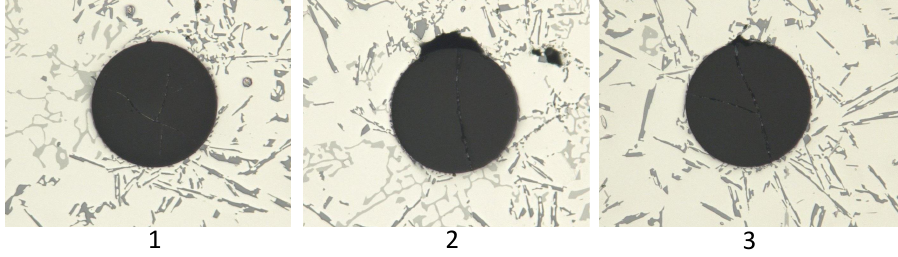
Figure 14. Cross-sections of three different probes where the fibre is located across the melt flow